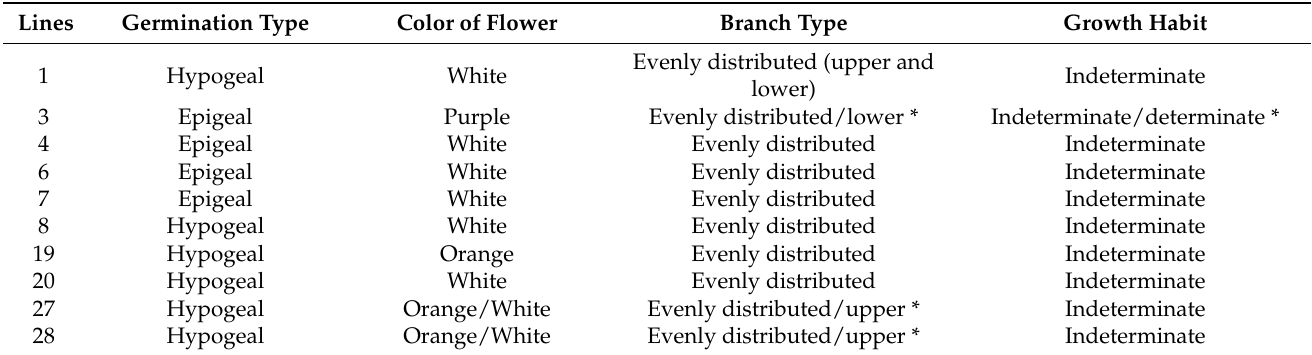
Table 1. Qualitative external traits evaluated in the different lines of P. coccineus based on the type of germination, flower color, type of branching and growth habit.